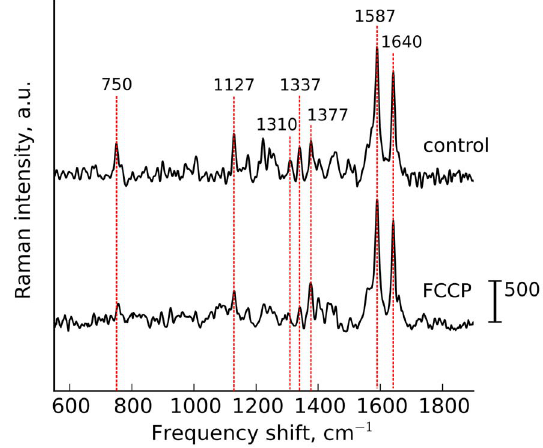
Figure 3. FCCP application. Raman spectra of perfused heart in control and under the application of protonophore FCCP (10 m M).